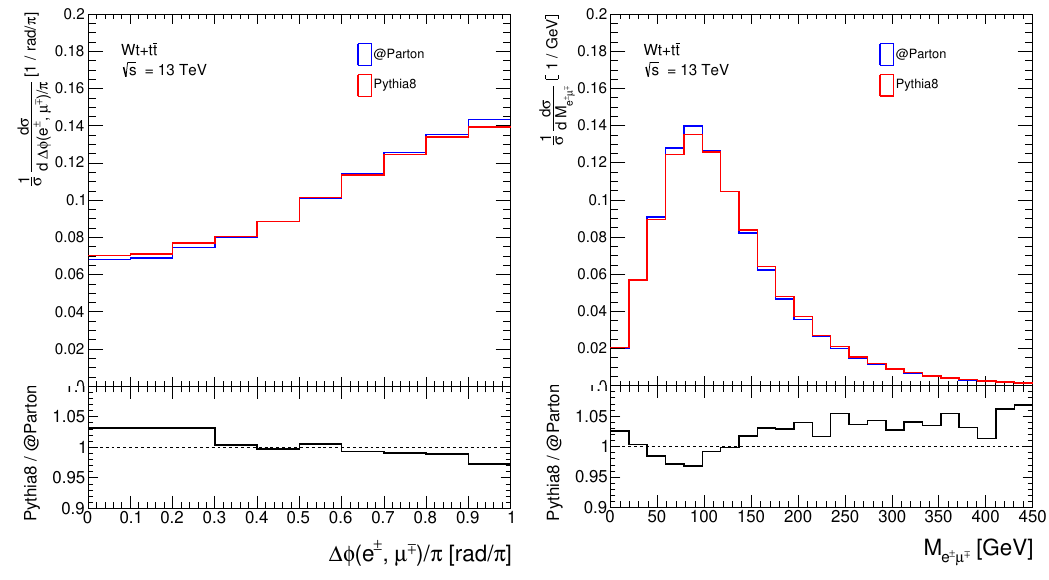
Figure 10 . Impact of additional gluon radiation on the QCD NLO description of tt and tW processes (see text). The left and right plots correspond to the di-lepton azimuthal angle di(cid:11)erence and the invariant mass,